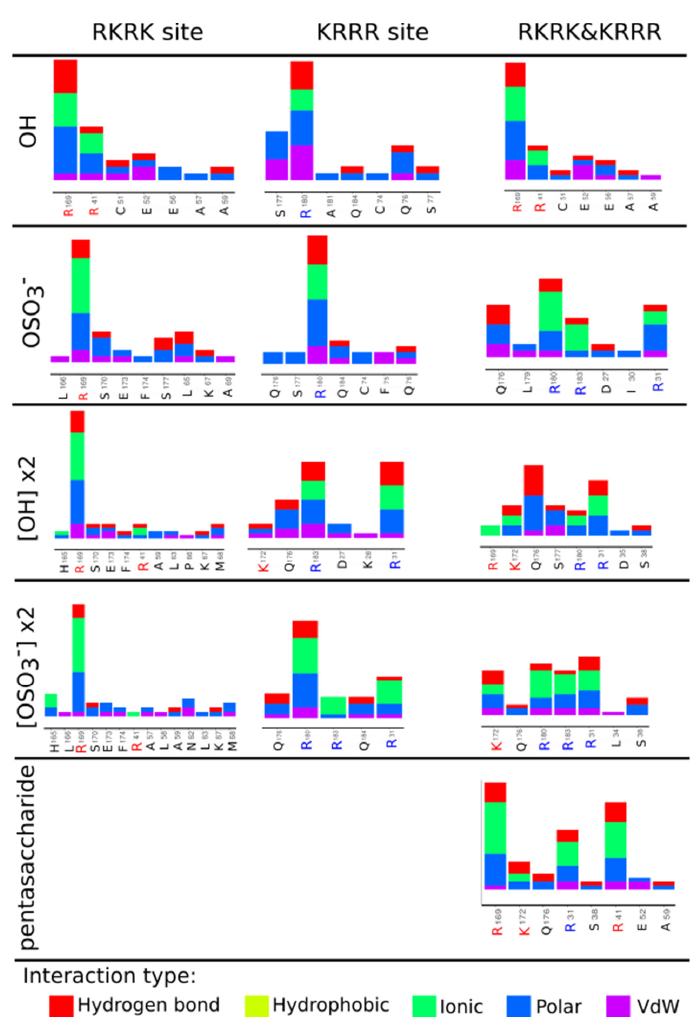
Figure 4. Arpeggio analysis for the different heparin structures to IL-6